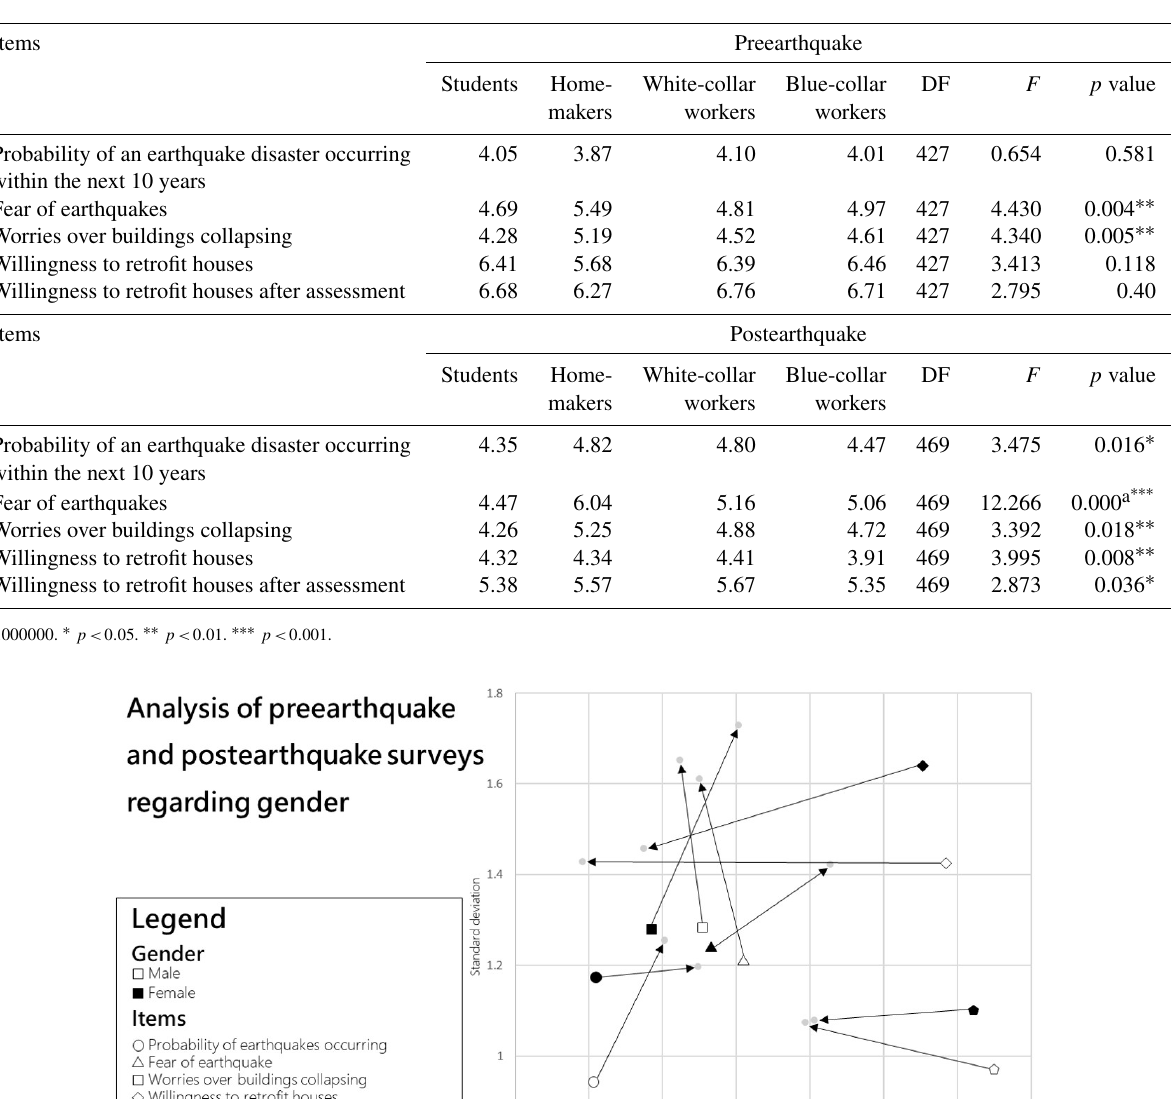
Table 7. p values and means for occupation.